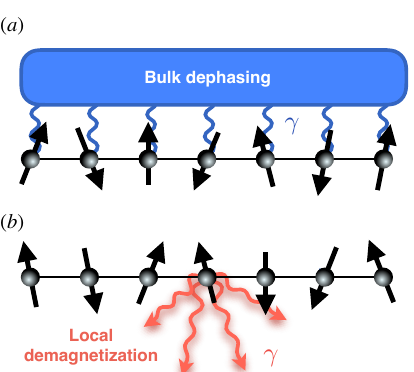
Figure 1: The sketch of the spin models with ( a ) bulk dephasing where all spins are coupled to the bath and ( b ) local demagnetization where the central spin is disspa-